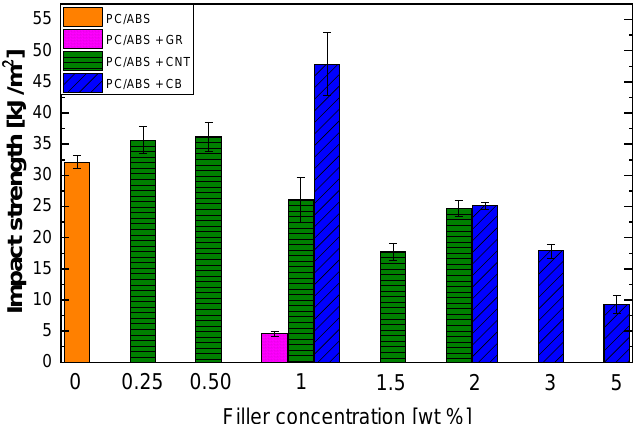
Figure 9. Impact strength of composites obtained by melt blending at different fillers concentrations.